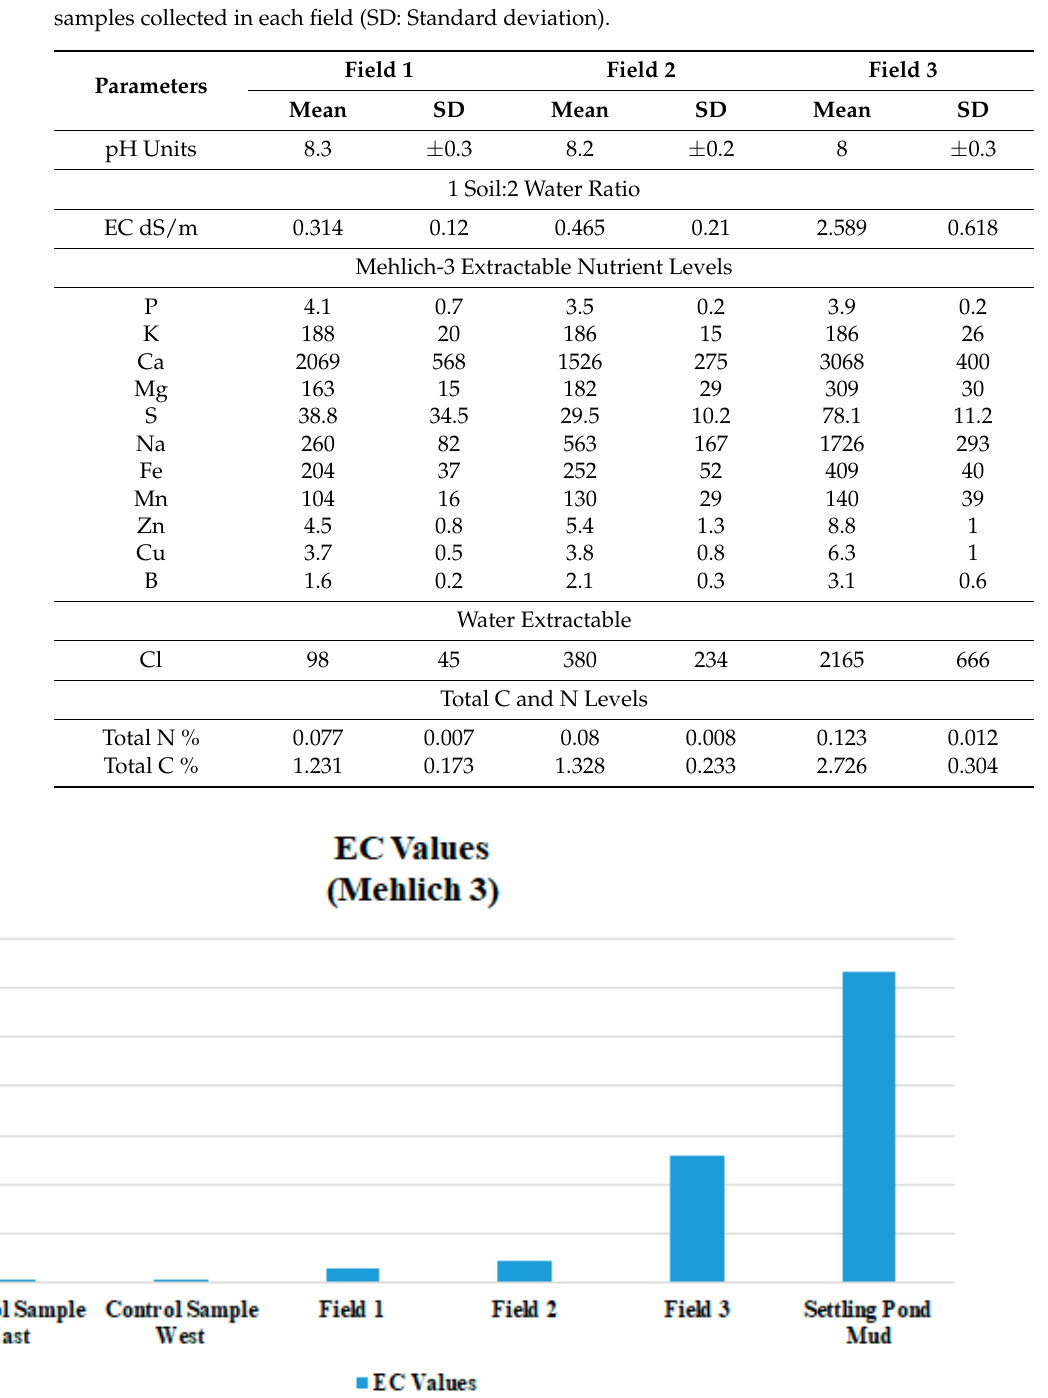
Figure 4. EC levels for three fields, two controls, and one settling pond sampled for study.